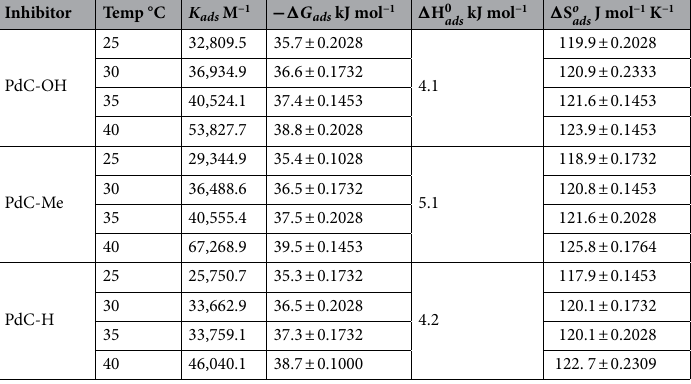
Table 5. Thermodynamic adsorption parameters of (PdC-OH, PdC-Me and PdC-H) adsorbed on the carbon steel surface in 1 M HCl acid at various temperatures.